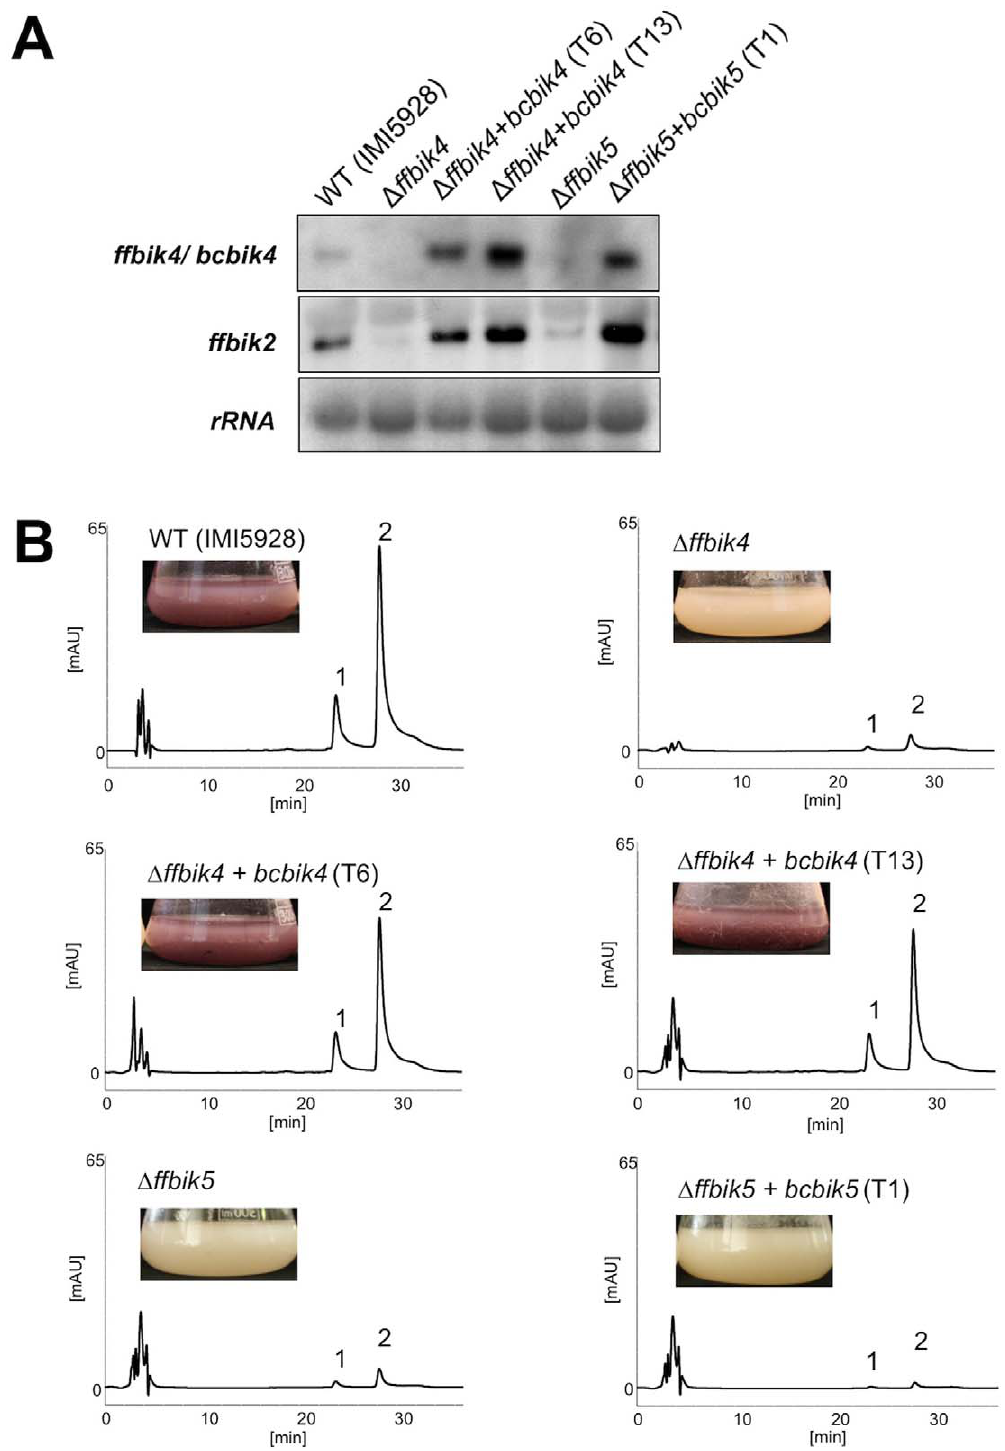
Figure 3. Heterologous expression of bcbik4 and bcbik5 of the gray strain B05.10 in the respective Fusariumfujikuroi (IMI58289) deletion mutants. A. Expression of ffbik2 and ffbik4/bcbik4. Wild type (IMI58289) and mutants were grown for three days in 10% liquid ICI (0.6 mM glutamine) medium at 28 u C and 180 rpm. The northern blots were hybridized with probes for ffbik2 or simultaneously hybridized with probes for ffbik4 and bcbik4 . rRNA is shown as loading control. B. Identification of bikaverin and norbikaverin production. Wild type (IMI58289) and mutants were grown in liquid ICI medium containing 6 mM glutamine for three days. Samples were taken and used for HPLC-DAD analyses (detected at 450 nm) as described in Material and Methods. Peaks for norbikaverin (1) and bikaverin (2) are labeled in the chromatograms.